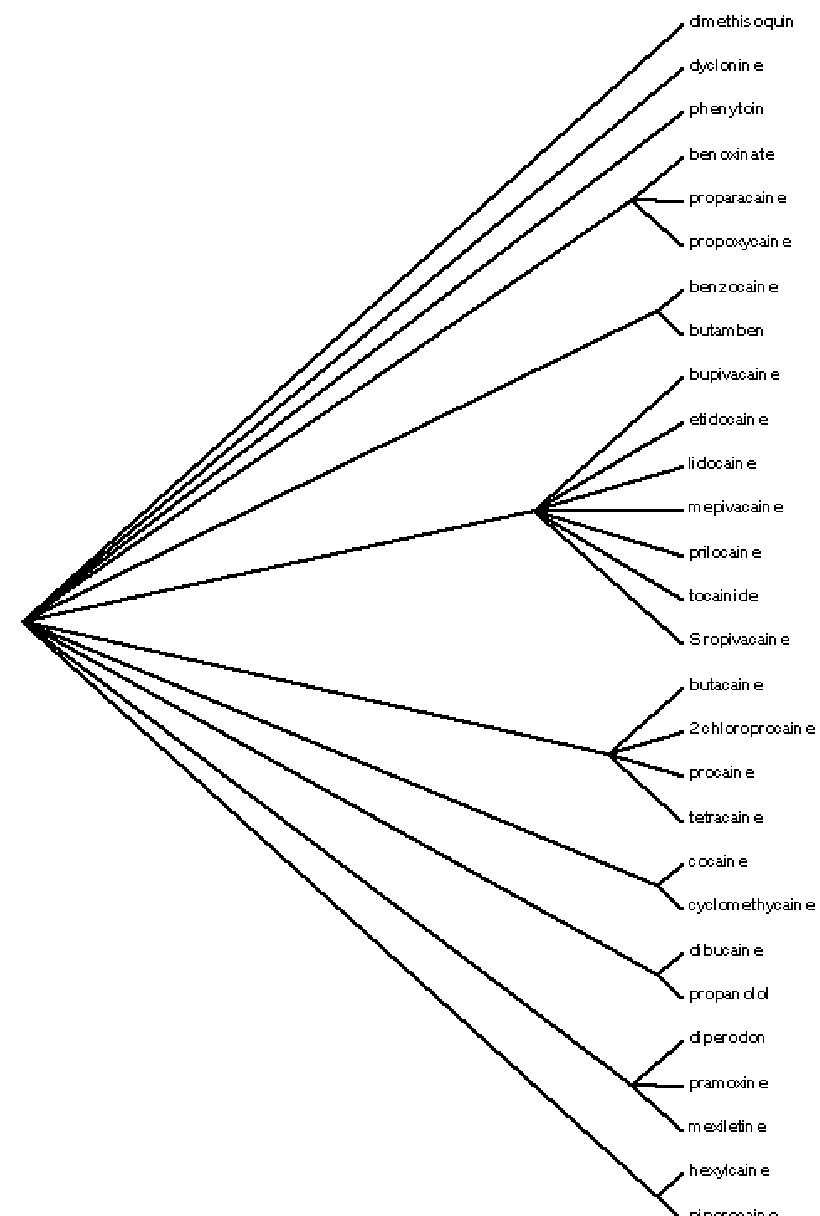
Figure 2. Dendrogram for the local anaesthetics analogues of procaine at level b The radial tree for the local anaesthetics relating to < i same 11 classes, in agreement with the partial correlation diagram, dendrogram (Figures 1–2) and previous results obtained for the first 27 entries in Table 1